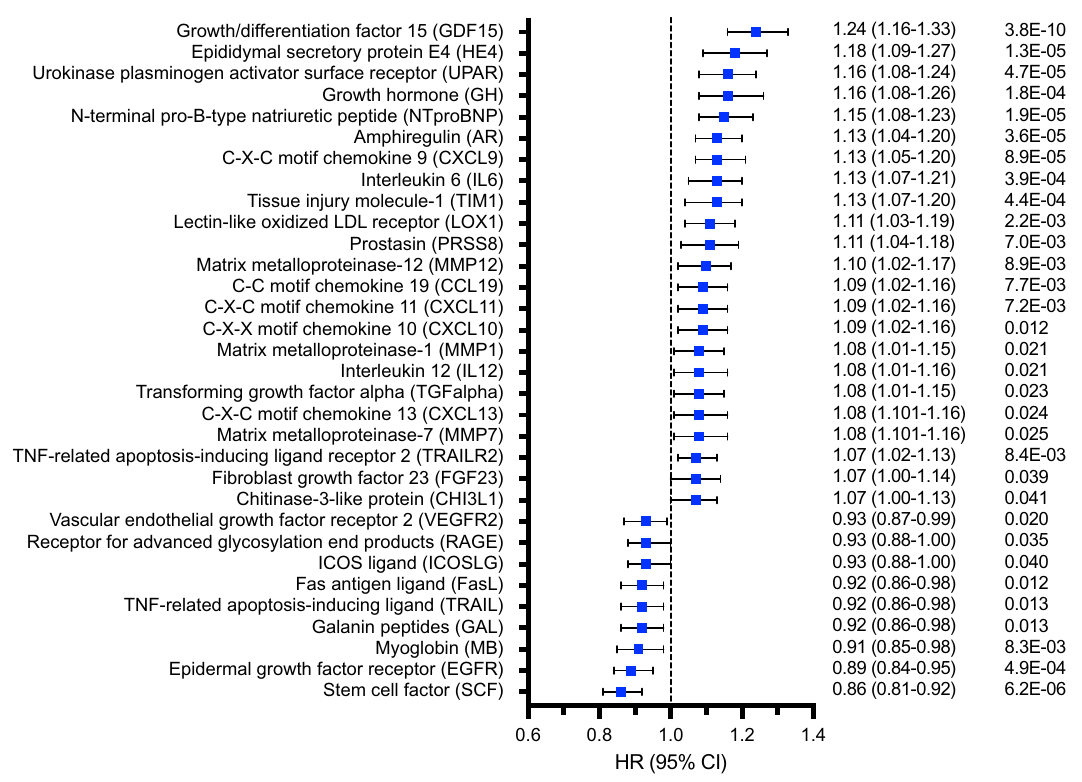
Figure 2. Forest plot of plasma proteins associated with risk of all-cause mortality with nominal significance level (P < 0.05) after covariate adjustment in the MDCS-CVA (n = 3,918). Hazard ratio (HR) and 95% confidence interval (CI) per standard deviation (SD) from a Cox regression model adjusted for age, sex, smoking status, BMI, educational level, history of hypertension, prevalent diabetes mellitus, C-reactive protein (ln-transformed), HbA1c (ln-transformed), and LDL-cholesterol. Bonferroni corrected significance threshold was P < 0.00036.